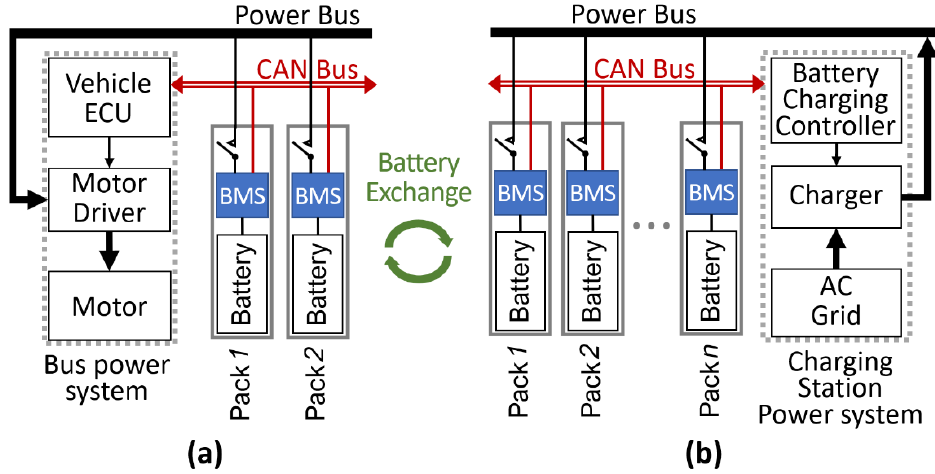
Figure 1. Battery exchange power system comprising SRB packs. The battery packs are connected either ( a ) to a bus power system in the power supply mode or ( b ) to a charging station in the recharging mode.